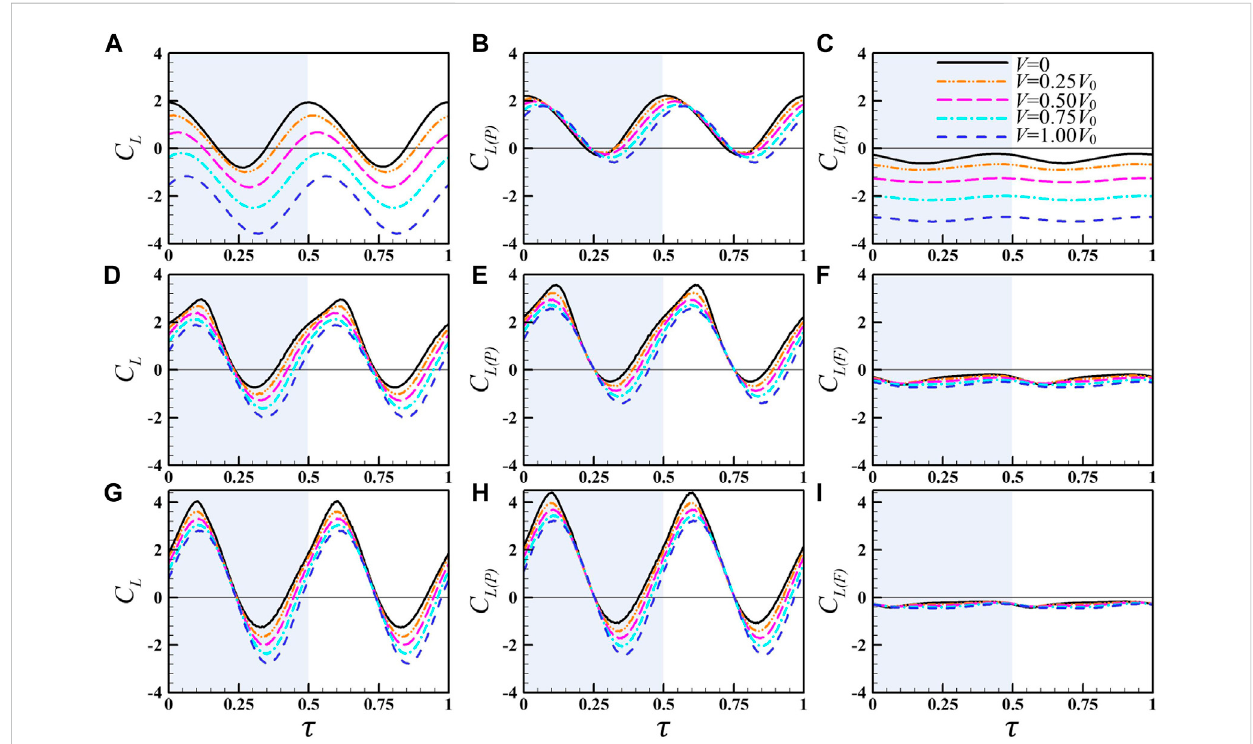
FIGURE 12 Instantaneous lift coef fi cients and its two components (the pressure-based lift and friction-based lift) of the wing for Φ (cid:1) 10 ° (A – C) , Φ (cid:1) 40 ° (D – F) , and Φ (cid:1) 70 ° (G – I) at different up- fl ight speeds V . Subscripts “ P ” and “ F ” in the symbols represent the pressure- and friction-based components of the lift, respectively.